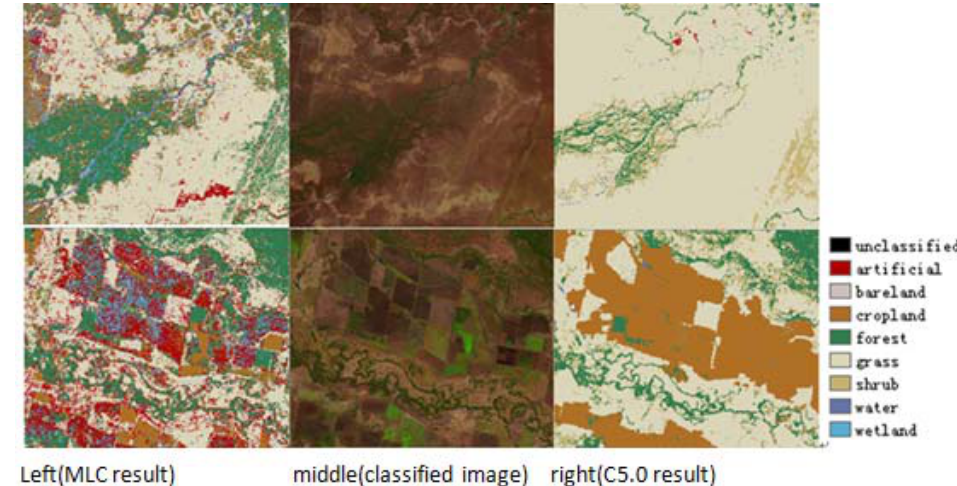
Figure 4. Some comparisons of MLC result and C5.0